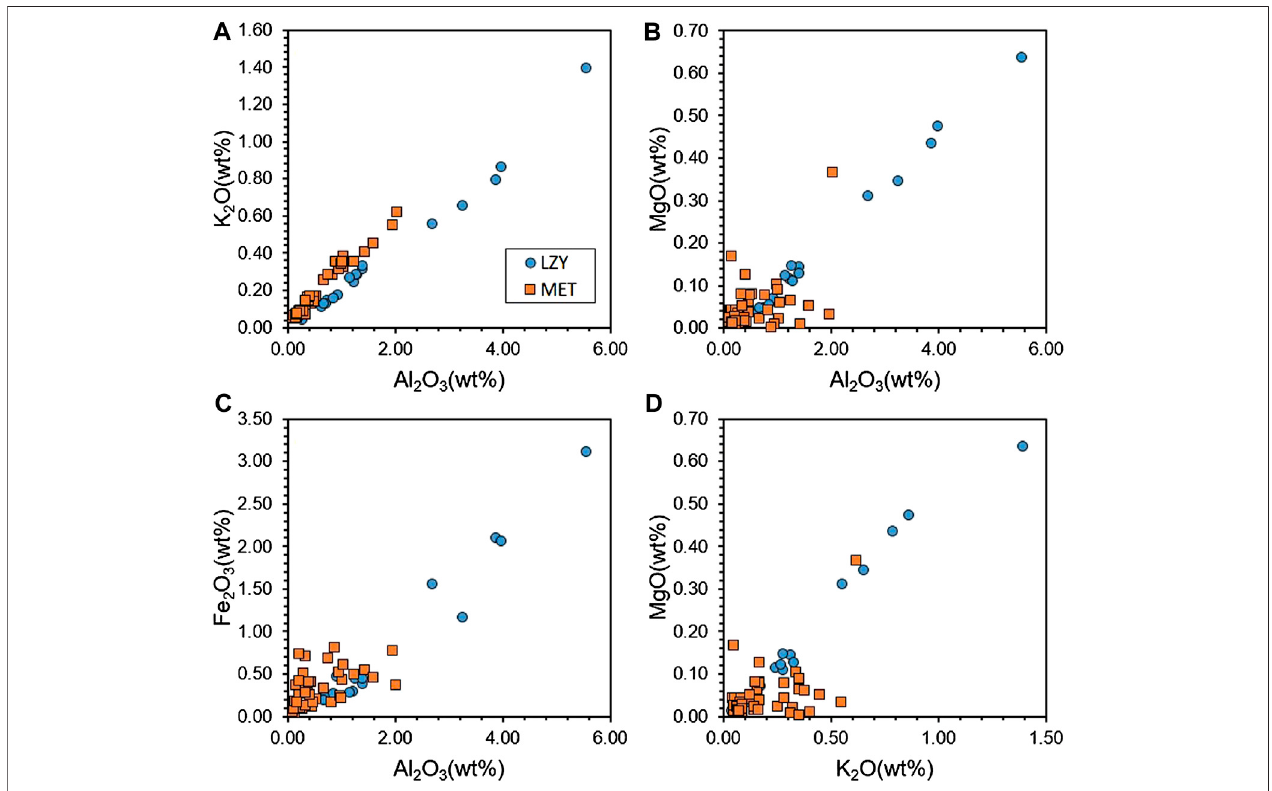
FIGURE4| Crossplotsshowingthecorrelationsbetweenmajorelementcontents(measuredasoxidesinwt%). (A) Al 2 O 3 vs.K 2 O; (B) Al 2 O 3 vs.MgO; (C) Al 2 O 3 vs. Fe 2 O 3 ; and (D) K 2 O vs.